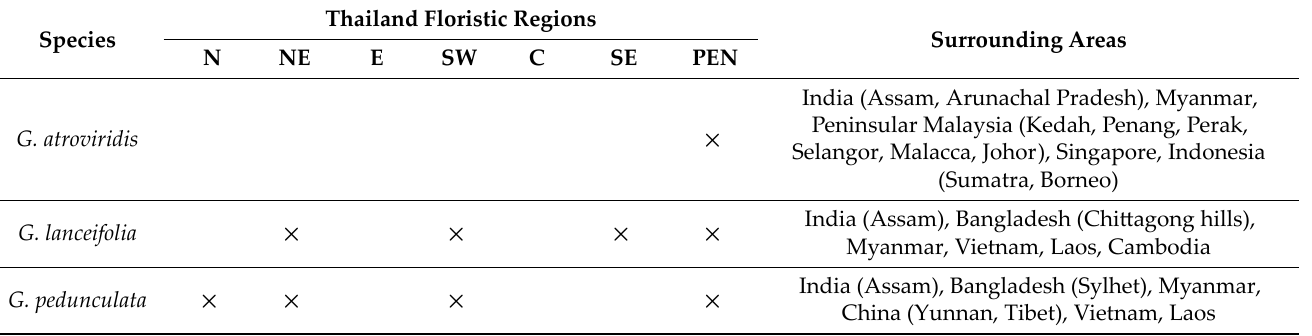
Surrounding Areas